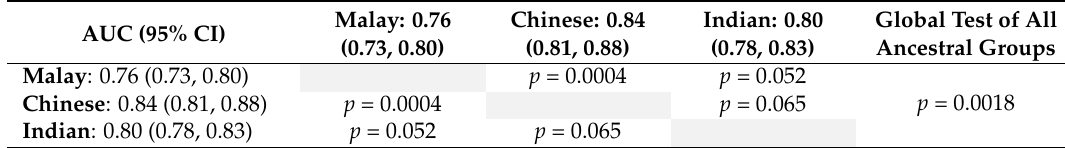
Table 4. Area under the receiver operating characteristic curves (AUC) with 95% confidence interval (CI) for each ancestral group, and p -values from comparisons between groups.